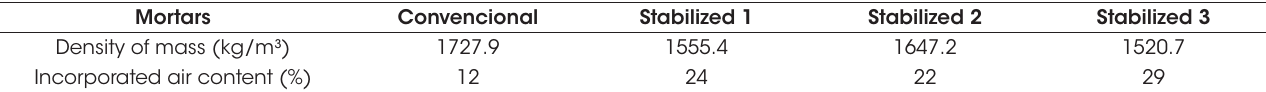
Density of mass and incorporated air content in the fresh state of mortars